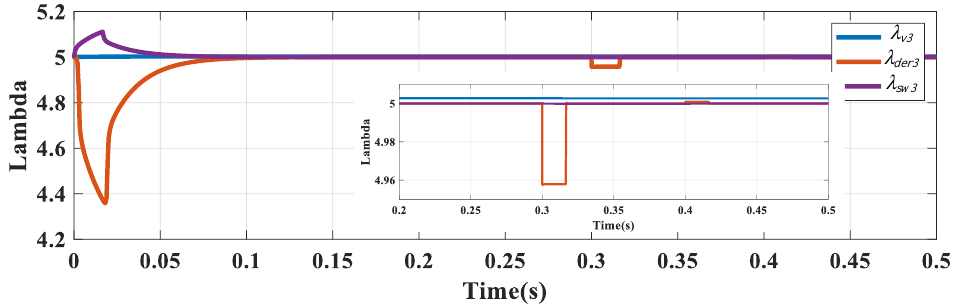
Figure 23. Study 3: generated weighting coefficients for FCS-MPC in